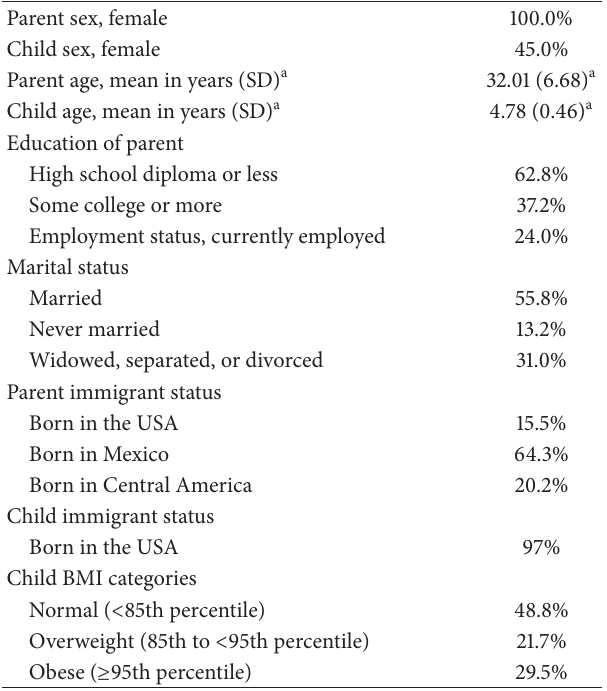
Table 1: Characteristics of the sample at the first time point ( 𝑛 = 129